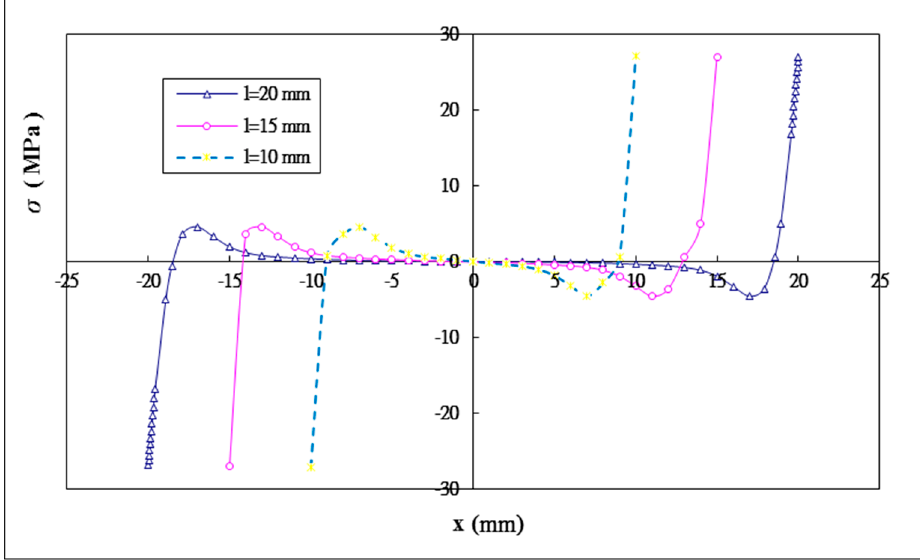
Figure 12. Peel stress distribution in the adhesive with three different bonding lengths.